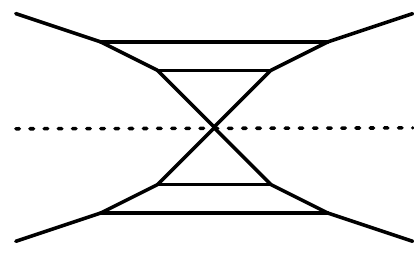
Figure 21 . Dual graph of the 5-brane web for 5d pure SU(2) gauge theory with discrete theta angle